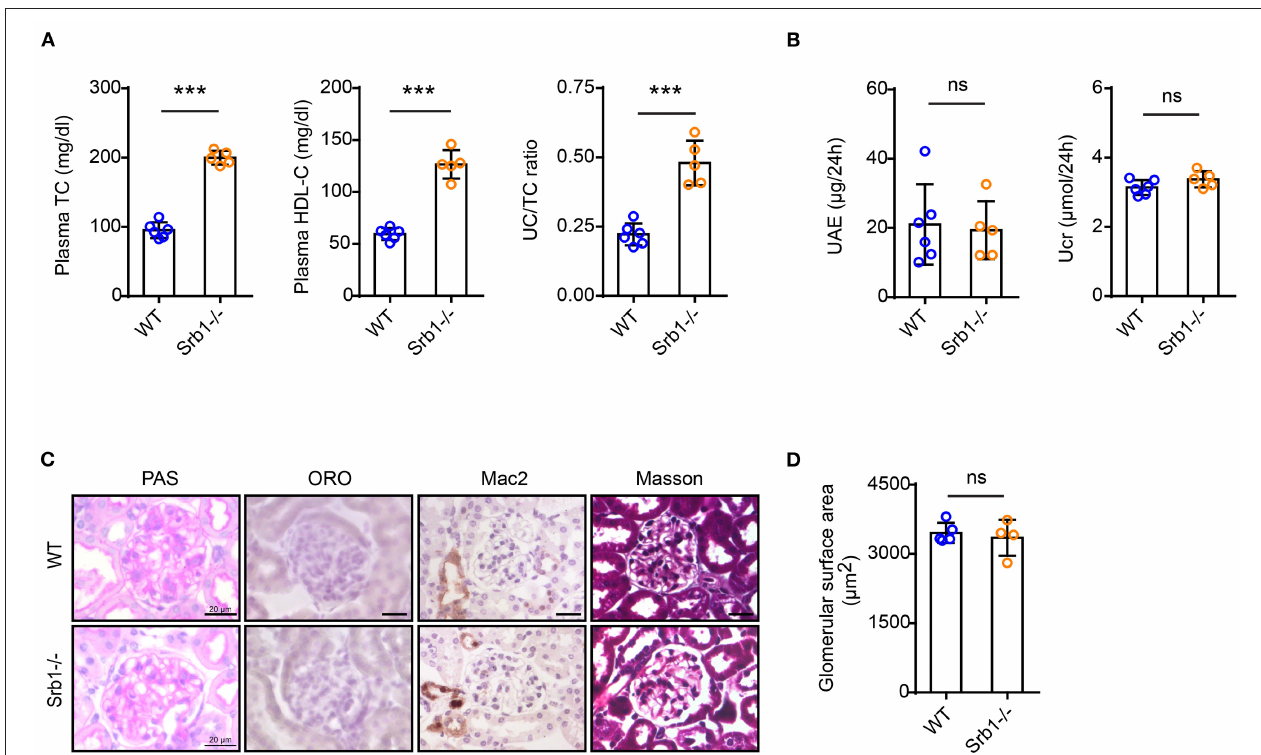
FIGURE 1 | Plasma lipid parameters and renal function/histology in Srb1-/- and wild-type mice fed on standard chow diet. (A) Plasma TC levels, HDL-C levels, and UC/TC ratios; (B) 24-h UAE and Ucr; (C) Representative glomeruli stained with PAS, ORO, Mac2, and Masson; (D) Glomerular surface area. n = 3–6 per group. ***: p < 0.001; ns: no